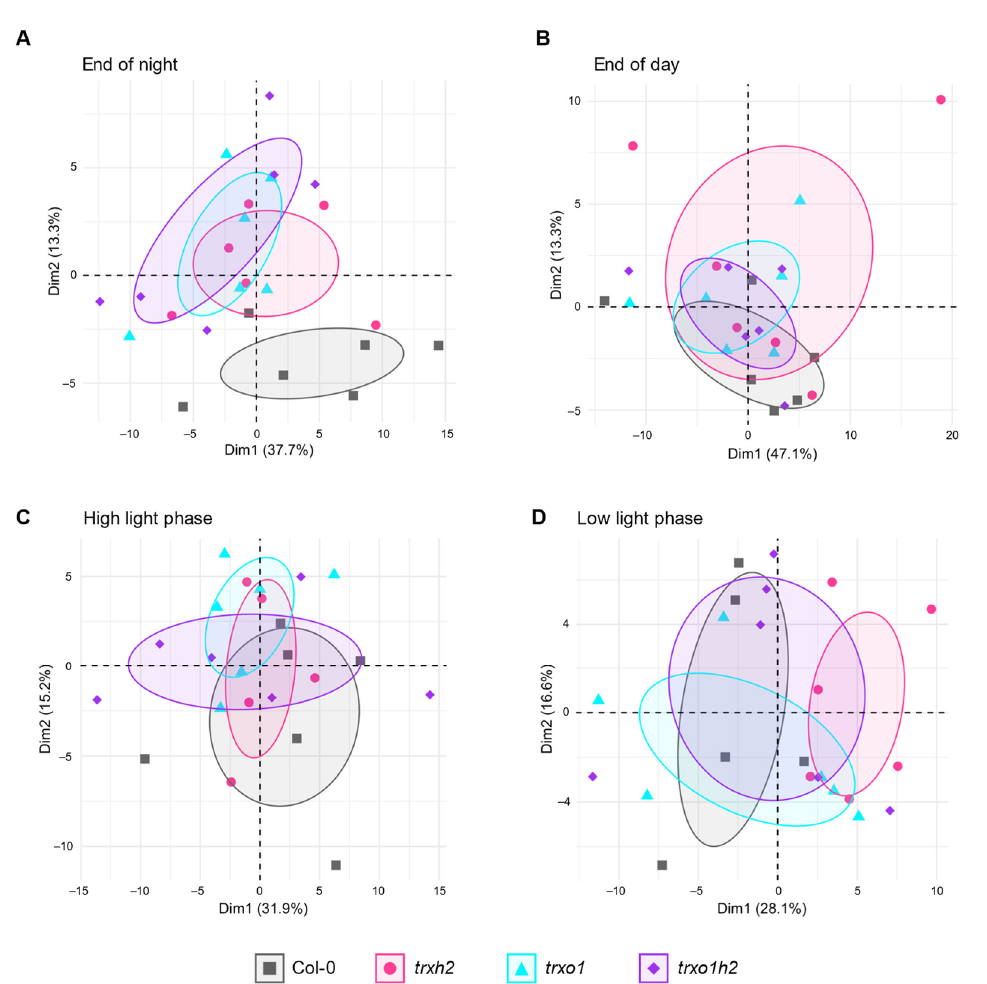
Figure 4. The principal component analysis on metabolite profile of the wild type (Col-0) and the mutant lines ( trxh2 , trxo1 and trxo1h2 ). Arabidopsis plants grown under medium light conditions were harvested at the end of the night ( A ) and the end of the day ( B ), respectively. Arabidopsis grown under fluctuating light conditions were harvested at the high-light phase ( C ) and low-light phase ( D ), respectively. The samples were used for metabolite profiling via GC-TOF-MS, and the results were used for principal component analysis by using R software. Dim 1: 1st principal component; Dim 2: 2nd principal component.